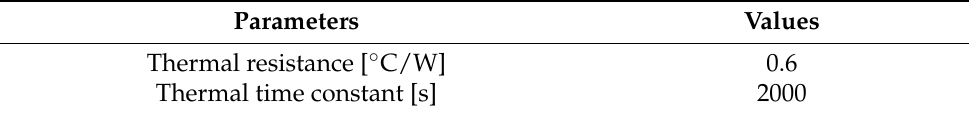
Table 1. Batteries Thermal parameters.